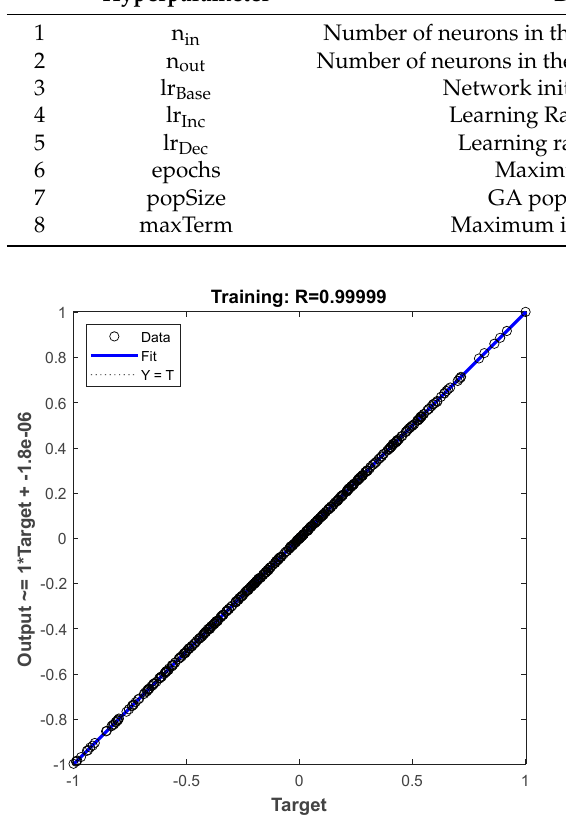
Figure 6. Network training regression rate.